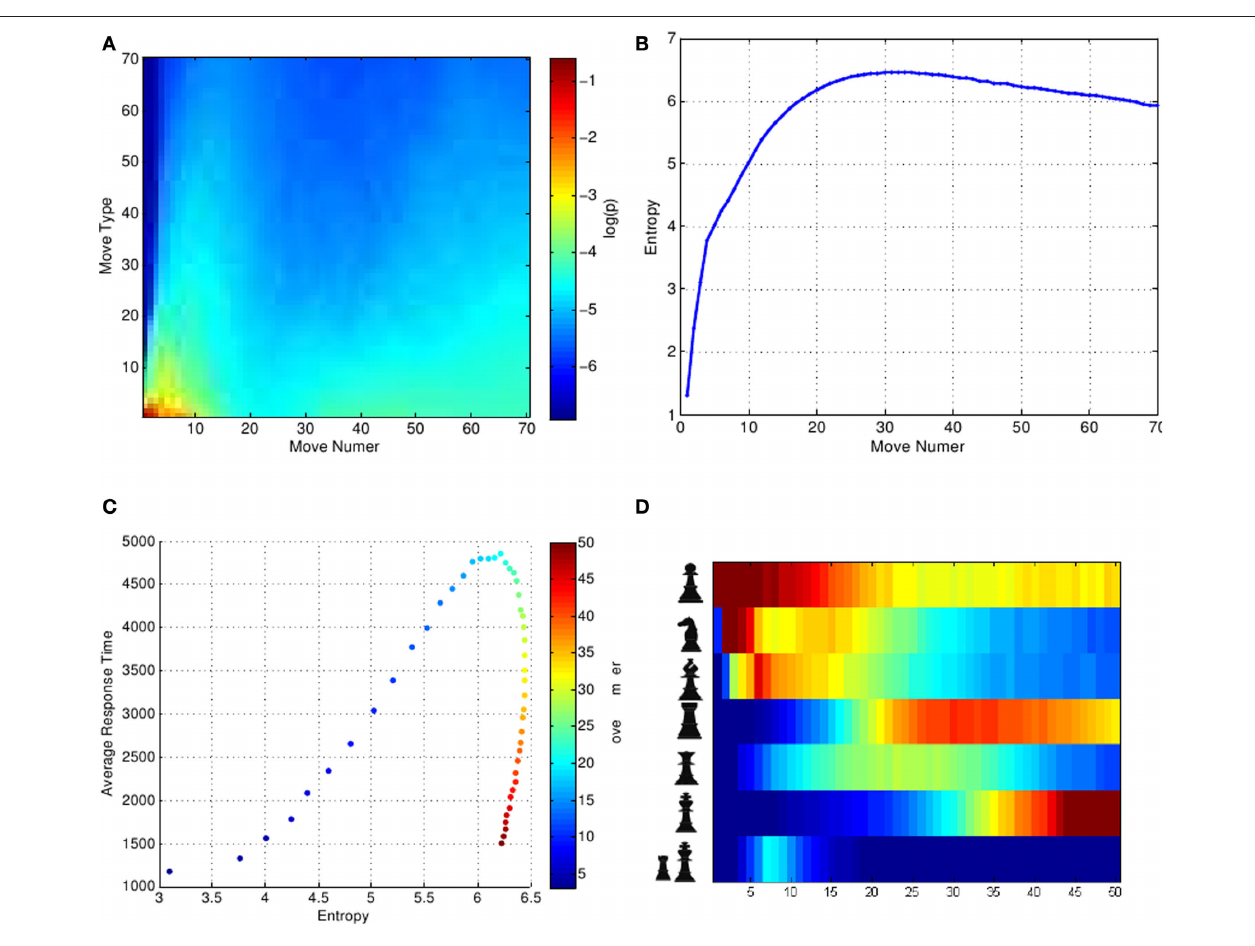
Figure 2 | entropy and distribution of move time depending on move number. (A) Probability of the 70 most frequent move-types for each move number ( x -axis). Probability is color coded and move-types were sorted in the y -axis by rank. (B) Entropy of the move-type distribution for different move numbers. Entropy increases rapidly and then shows a moderate decrease during the endgame. (C) During the first moves, entropy of move-type distribution ( x -axis) and mean duration ( y -axis) covary. During the endgames (red